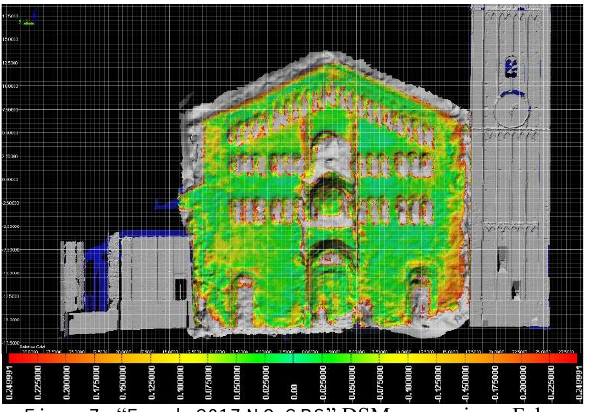
Figure 7. “Façade 2017 NO GPS” DSM comparison. False colour representation.